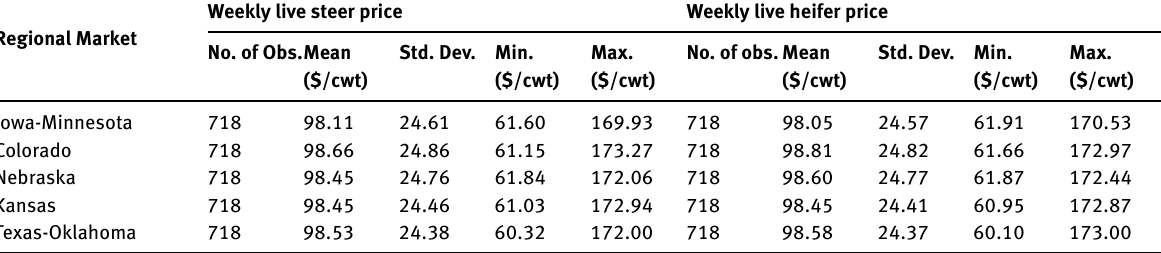
Table 1: Summary Statistics of Weekly Steer and Heifer Prices, May 2001-March 2015 Regional Market